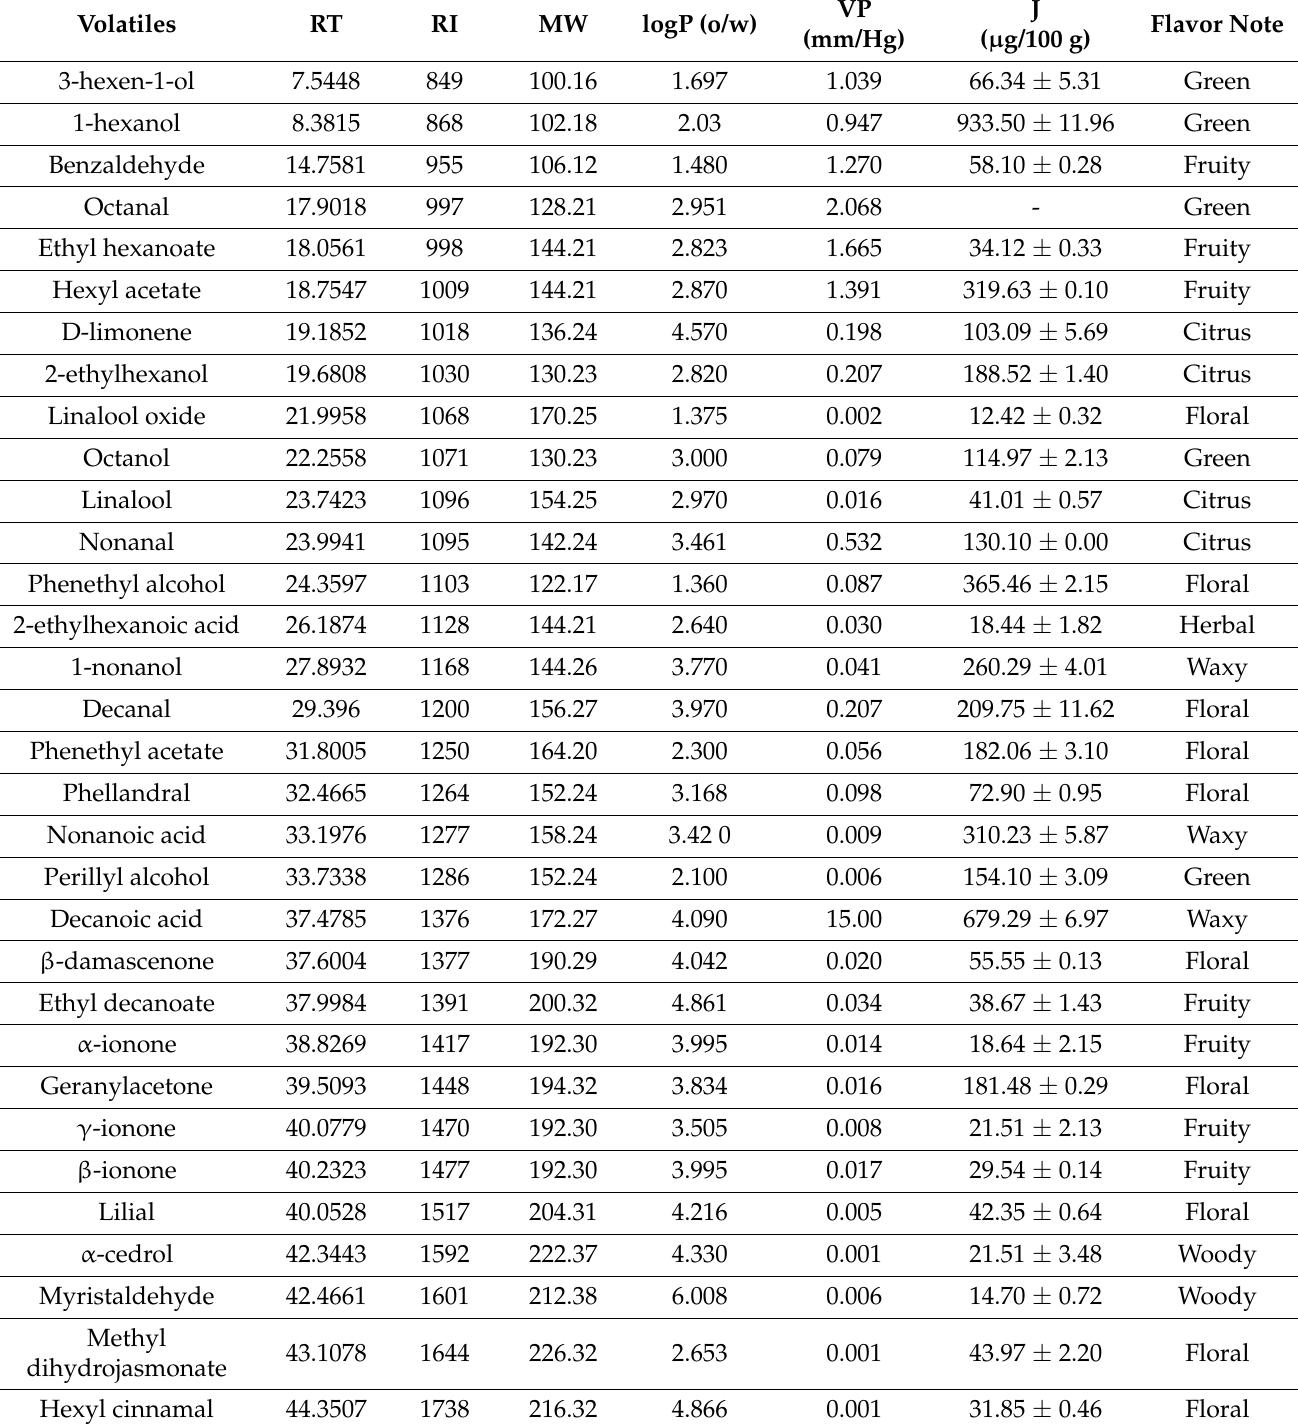
Table 5. Physicochemical properties, flavor notes and amount of volatiles (J) in chokeberry